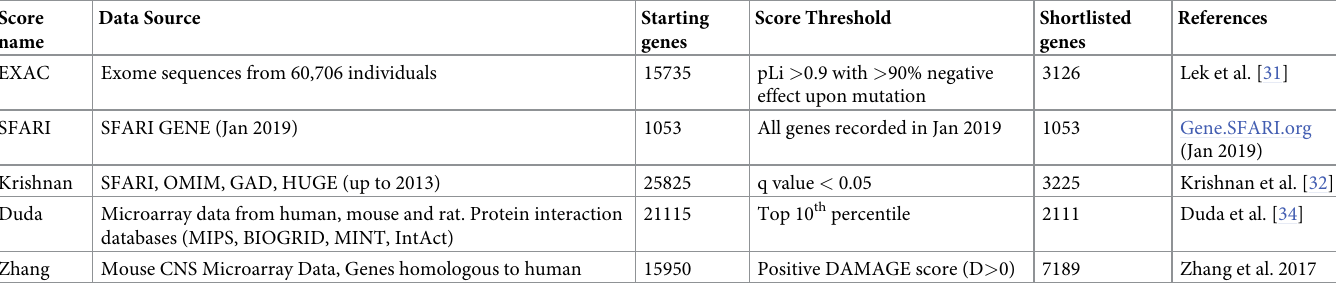
Table 1. Overview of five datasets and the independent scoring systems used to shortlist ASD genes for overlapping analysis.